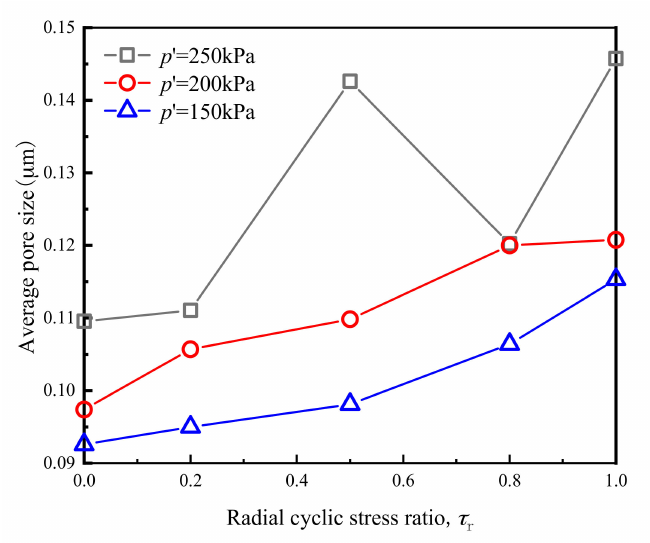
Figure 18. Average pore diameter of soft clay under the influence of τ